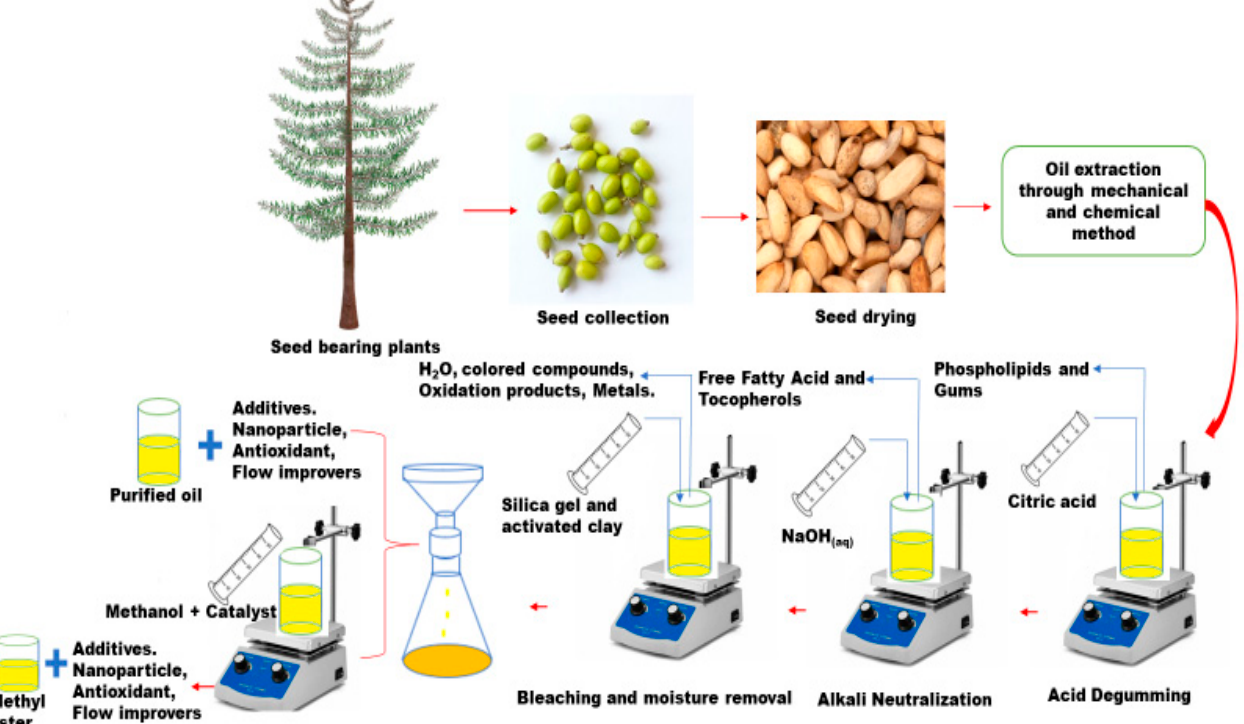
Figure 1. Synthesis of bio-based insulating oil.